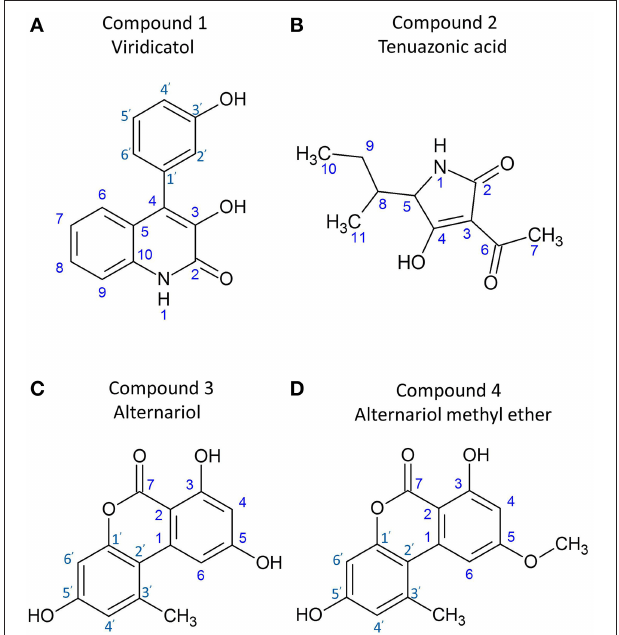
FIGURE 6 | Structures of the purified anti- Fusarium compounds from endophyte WF4. Shown are the structures for: (A) viridicatol alkaloid, (B) tenuazonic acid, (C) alternariol, and (D) alternariol monomethyl